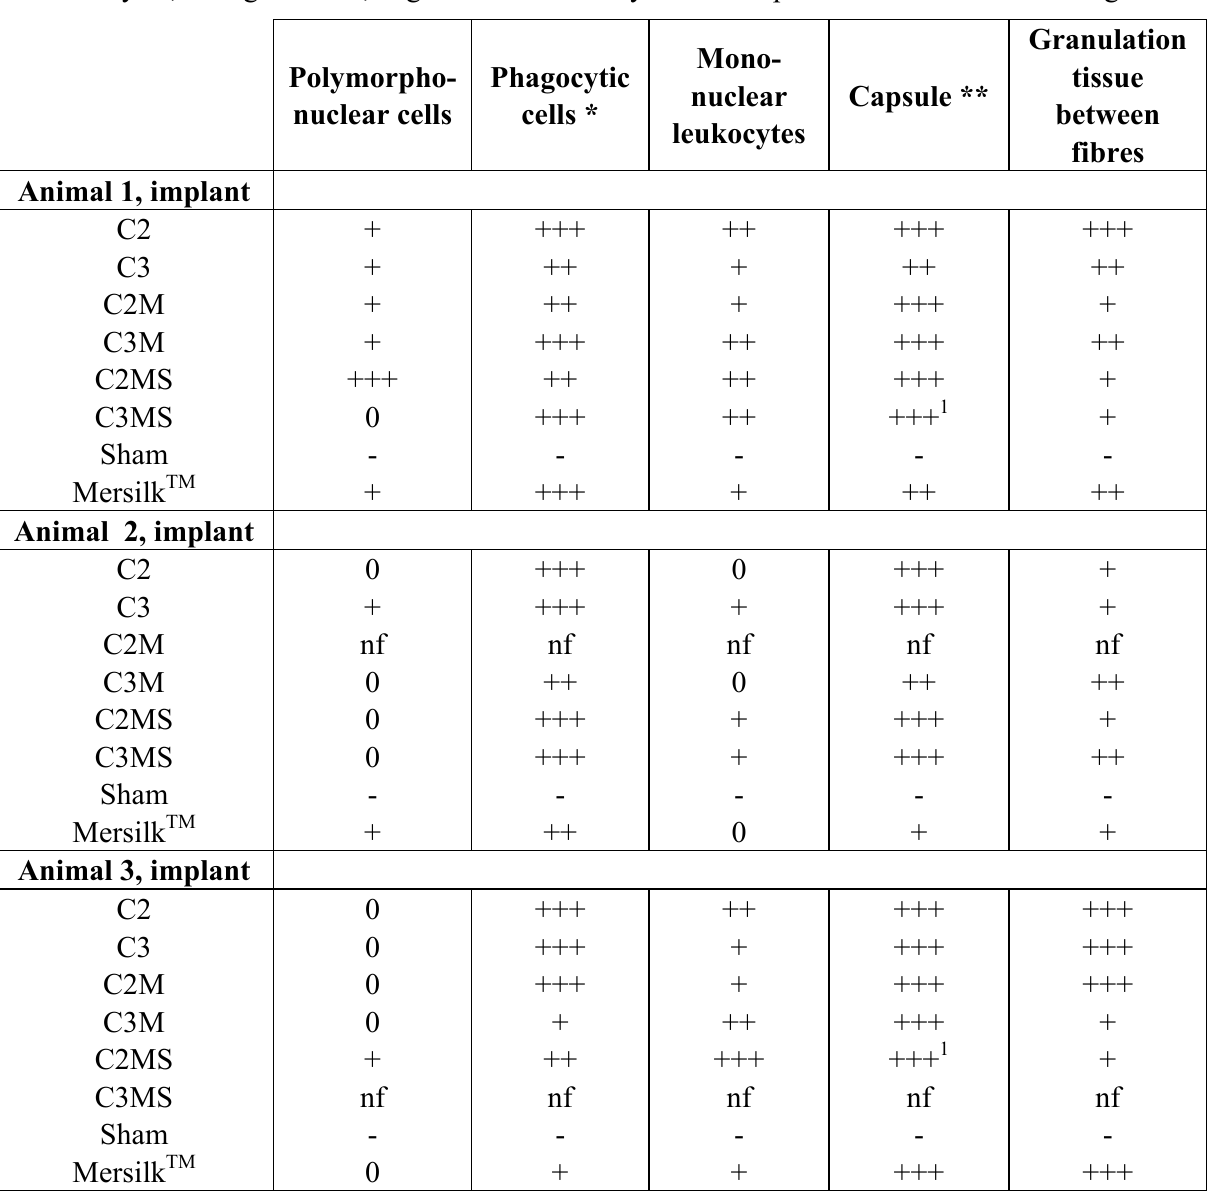
Table 3. Histopathologic assessment. The implants are listed to the left, for each individual. Abbreviations; C2, C3, C2M, C3M, C2MS, C3MS corresponds to the different 4RepCT fibre treatments (see experimental section and Table 1). Each implant has been rated according to the cell numbers/intensity of the lesions; +: low numbers of infiltrated leukocytes/mild changes. ++: intermediate numbers of infiltrated leukocytes/moderate changes. +++: numerous infiltrated leukocytes/severe changes. 0: not observed/ very low numbers of infiltrated leukocytes. nf: implant was not found at histological